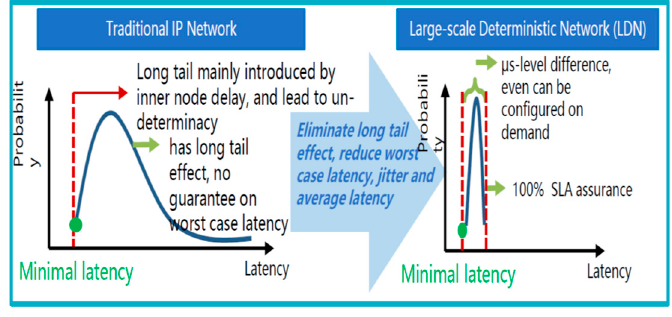
Figure 1. Latency performance of the traditional IP networks ( left ) is contrasted with the performance of future wide area/large-scale deterministic networks ( right ).